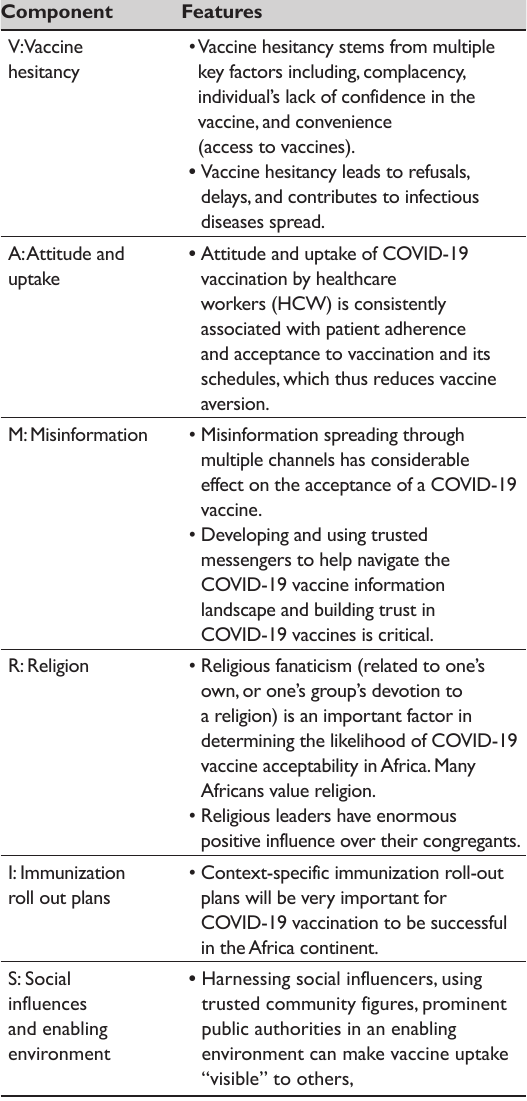
Table 1: Description of the Key features